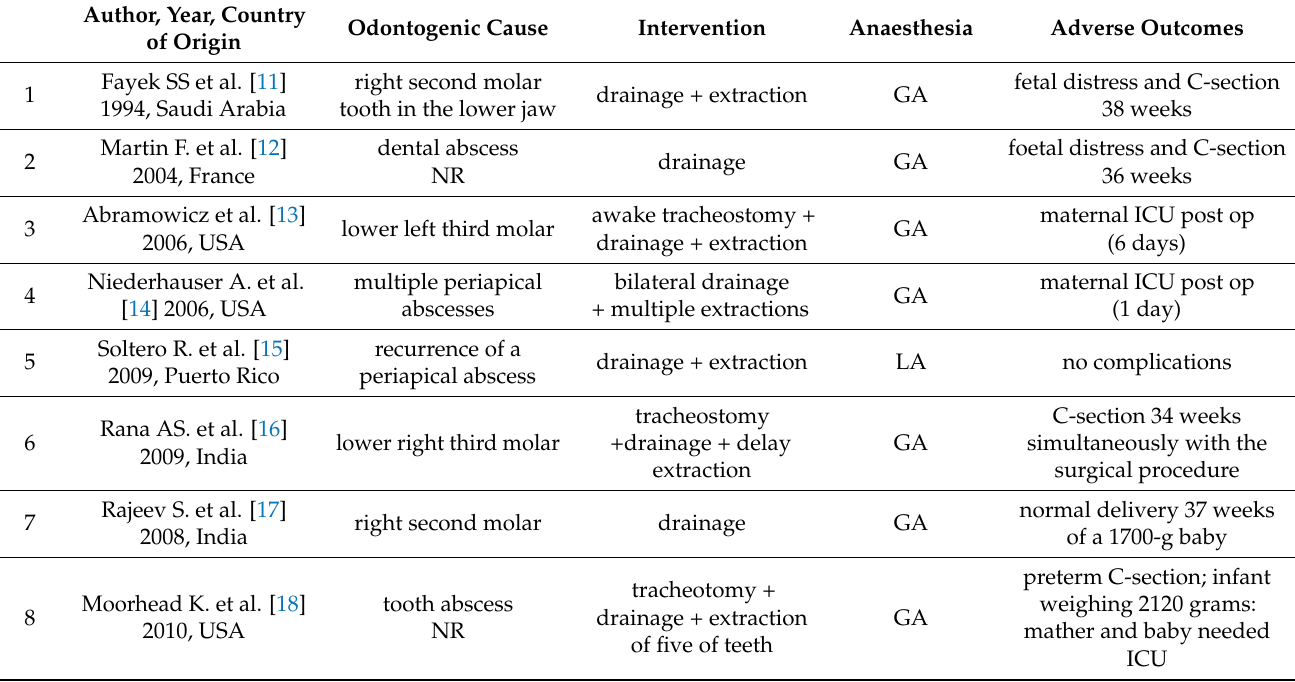
Table 3. Summary of odontogenic cause, surgical treatment, and adverse